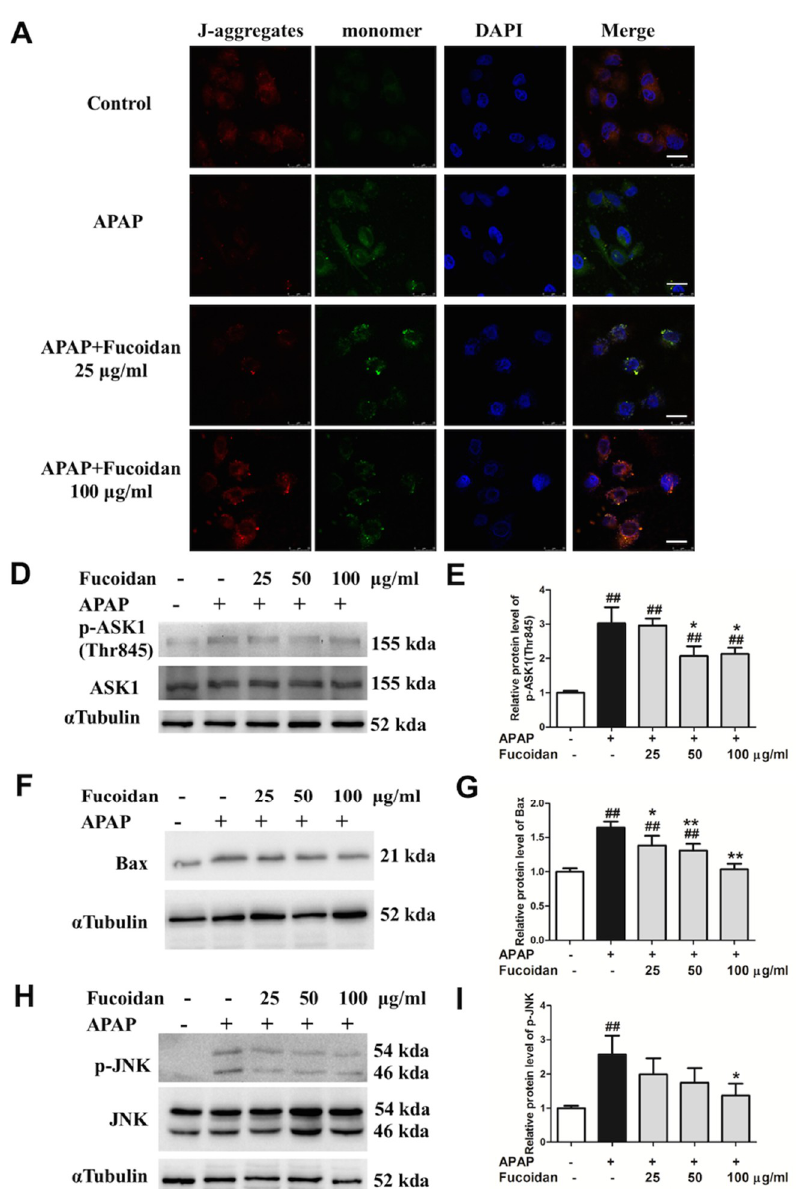
Figure 7. Effect of fucoidan treatment on APAP-induced mitochondrial membrane potential (MMP) and the JNK pathway in HL-7702 cells. Cells were treated with various concentrations of fucoidan (25, 50, or 100 µ g/mL) for 4 h, and were subsequently exposed to APAP (20 mM) for 24 h. ( A ) The effect of fucoidan on mitochondrial membrane potential was tested using the JC-1 method and determined by a confocal microscope. The J-aggregates produced red fluorescence, and the monomer emitted green fluorescence (Bar = 25 µm). The nuclei were stained with DAPI (blue). ( B , C ) Expression of Bax, ( D – G ) phosphorylated ASK1, and phosphorylated JNK were determined by Western blotting analysis. Quantification of relative protein expression was performed by densitometric analysis, and α Tubulin was used as an internal control. Similar results were obtained from three independent experiments. All results were expressed as mean ± SD, n = 3, ## p < 0.01 versus control group; * p < 0.05, ** p < 0.01 versus APAP-treated group.